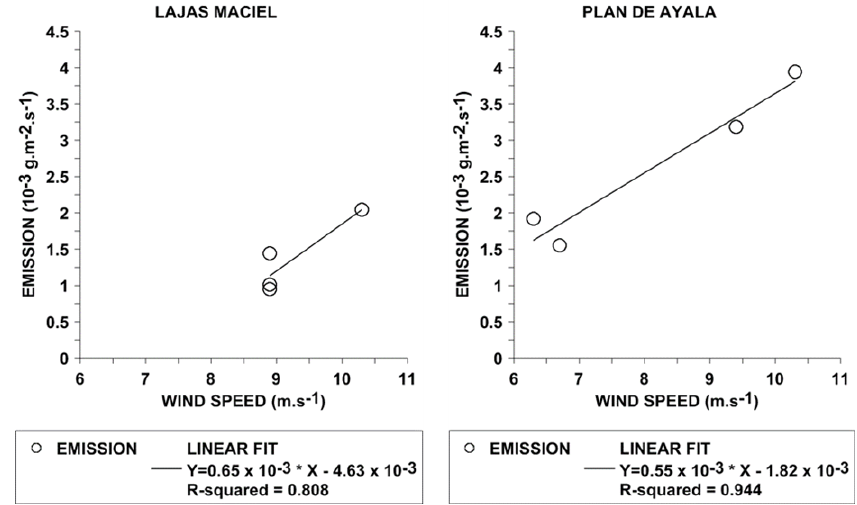
Figure 4. PM 10 dust emissions from unpaved roads as affected by wind speed for 12 February at Lajas Maciel and 21 February 2014 at Plan de